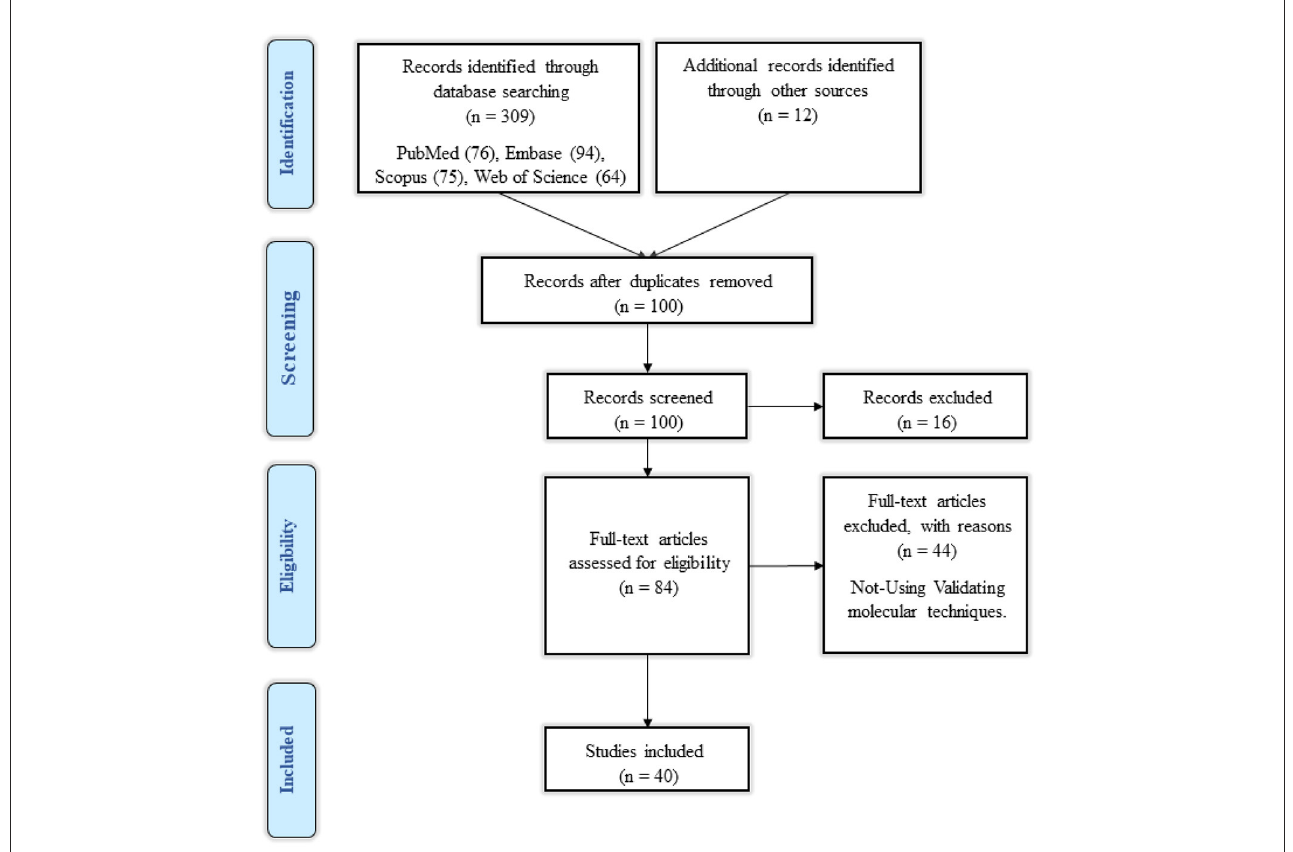
FIGURE1 Flow chart of search strategy based on PRISMA flow